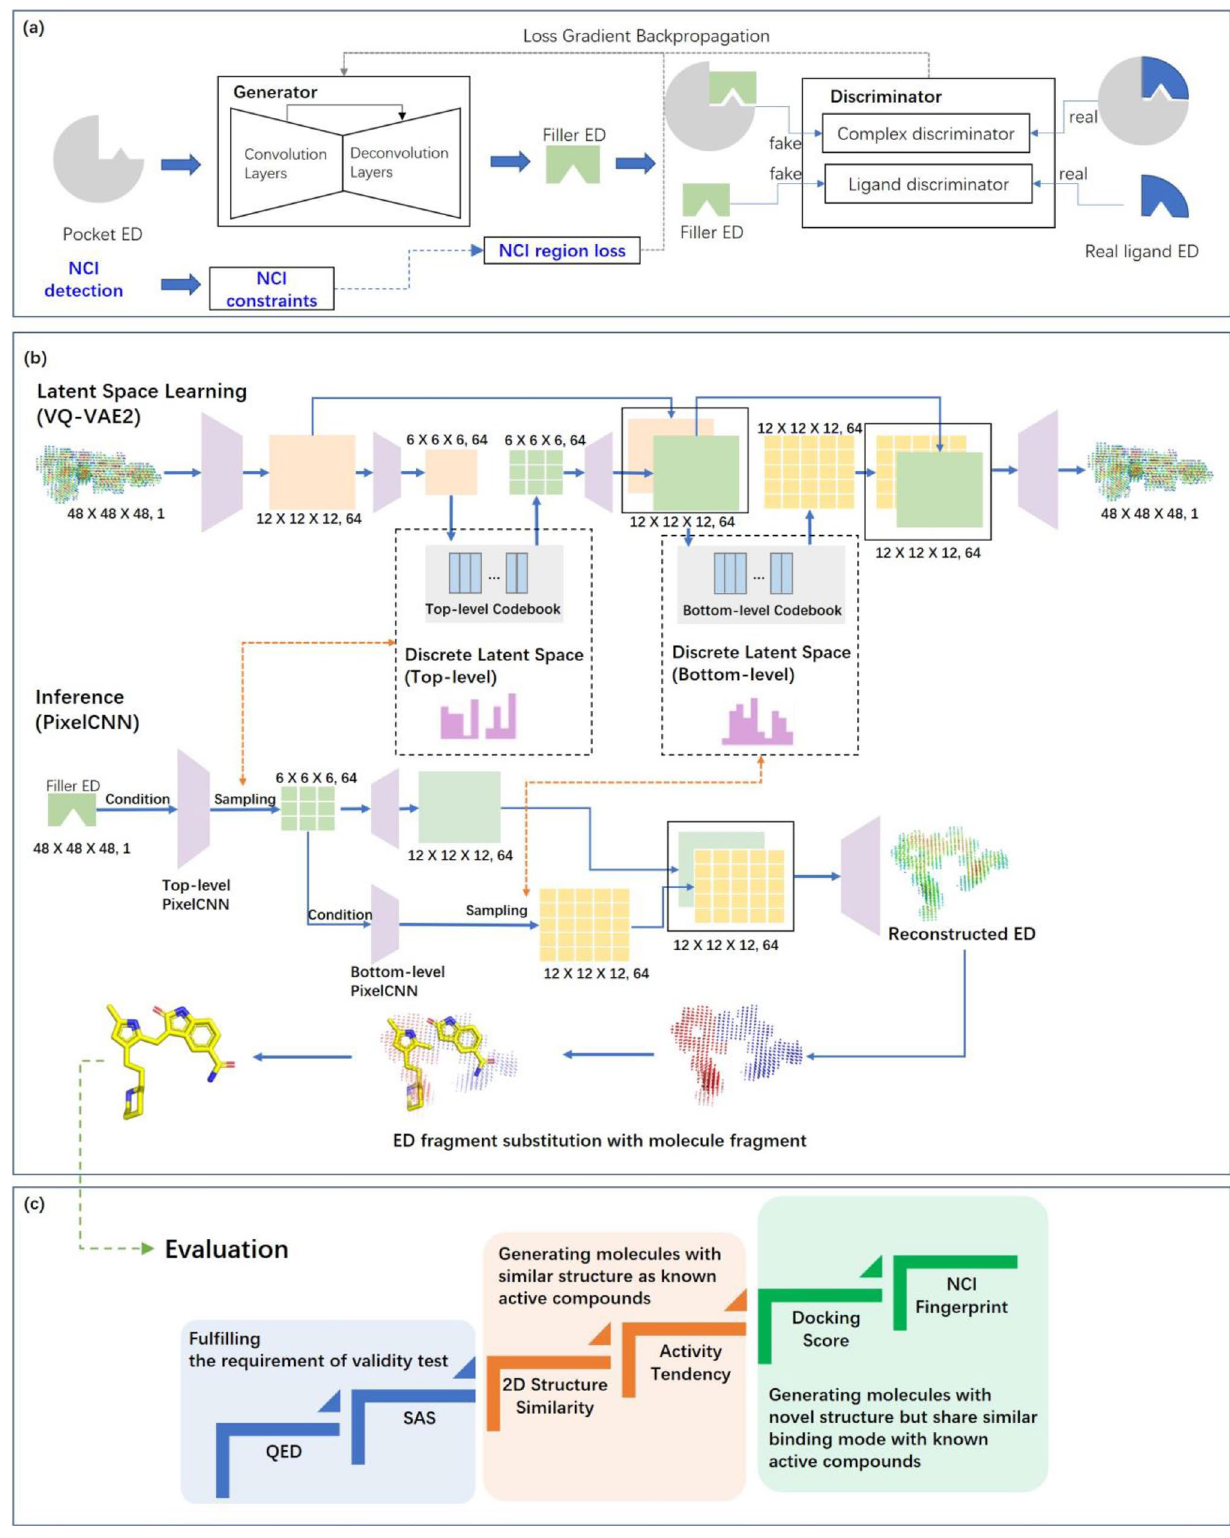
Figure 1. Model architecture. ( a ) The GAN for generating filler ED based on pocket ED. ( b ) ED interpretation module for molecule generation. VQ-VAE2 and PixelCNN used for latent space construction and autoregressive sampling, as well as the subsequent process of ED fragment substitution are illustrated. ( c ) The evaluation framework for generated